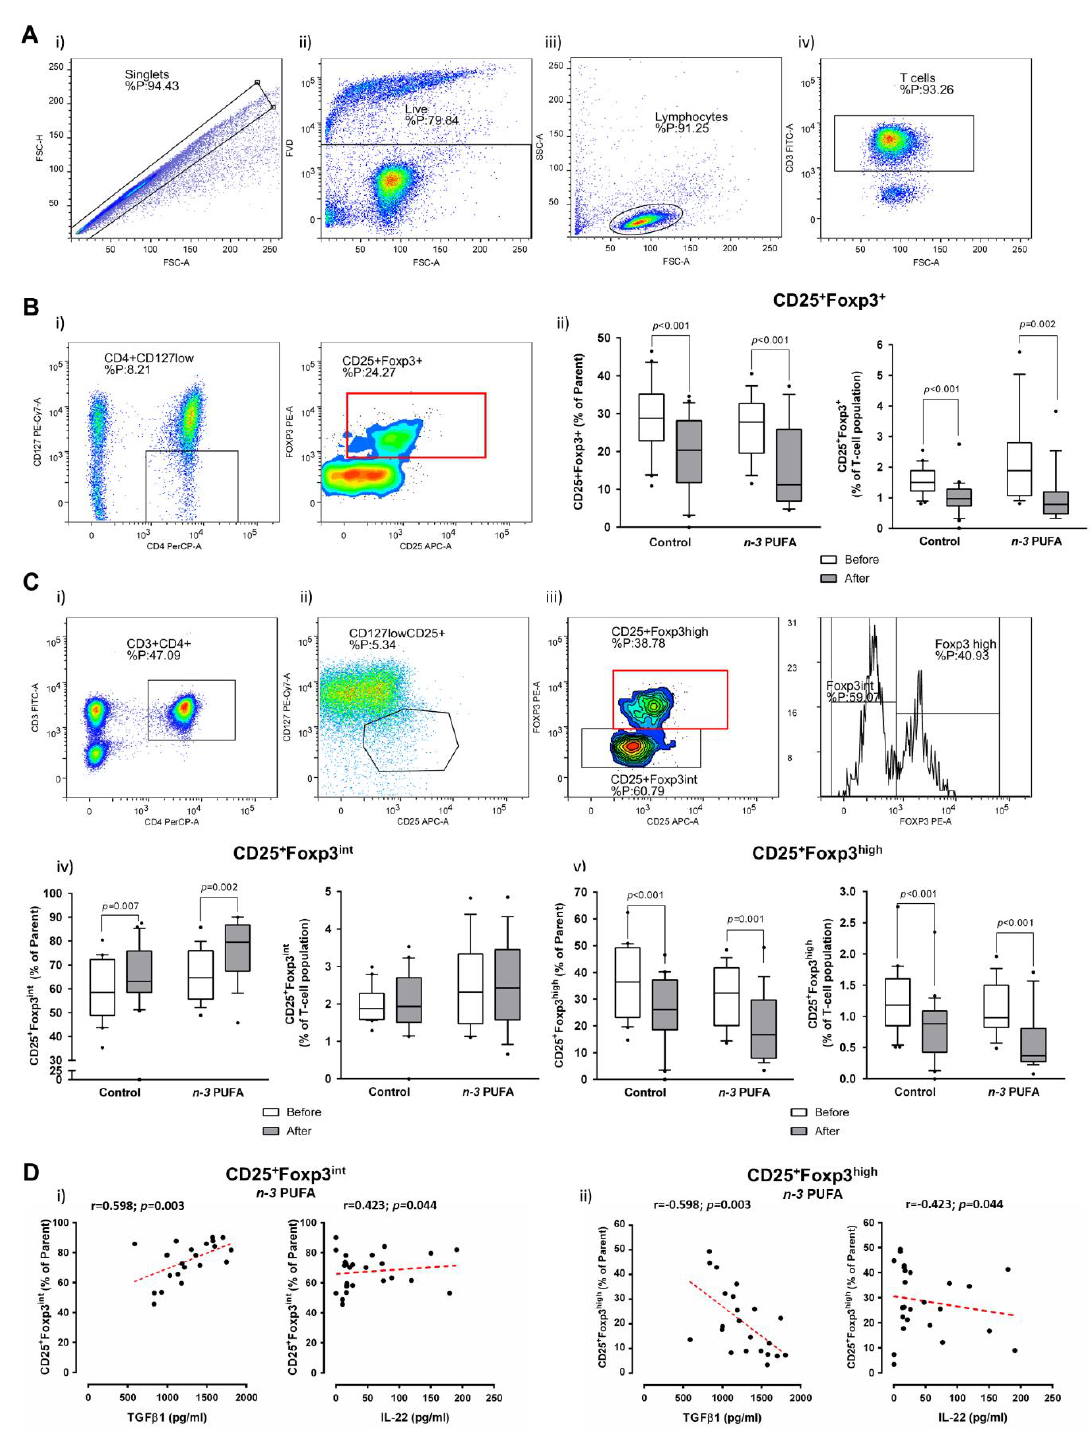
Figure 4. Effects of regular (control group) and n -3 polyunsaturated acid (PUFA)-enriched hen egg ( n -3 PUFAs group) consumption on the frequency of peripheral regulatory T cells (Treg) in healthy young individuals. ( A ) shows representative dot plots illustrating gating strategy, including exclusion of doublets using forward scatter area (FSC-A) versus forward scatter width (FSC-W) analysis (A-i), gating on live cells negative for amine-reactive fixable viability dye (A-ii), lymphocytes (A-iii) and CD3 + T cells (A-iv). First, total CD25 and Foxp3 expressing T cells among CD4 + CD127 low population were analysed ( B ). B-i shows representative gating strategy, while the relative frequencies are presented as box-and-whisker plots at B-ii. Next, we have analysed CD25 + CD127 low subpopulation (C-ii) of T helper lymphocytes (CD3 + CD4 + ) (C-i) for